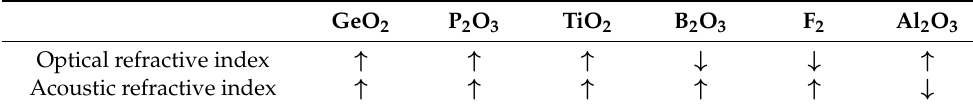
Table 1. Trend of optical and acoustic refractive index with different dopants in silica